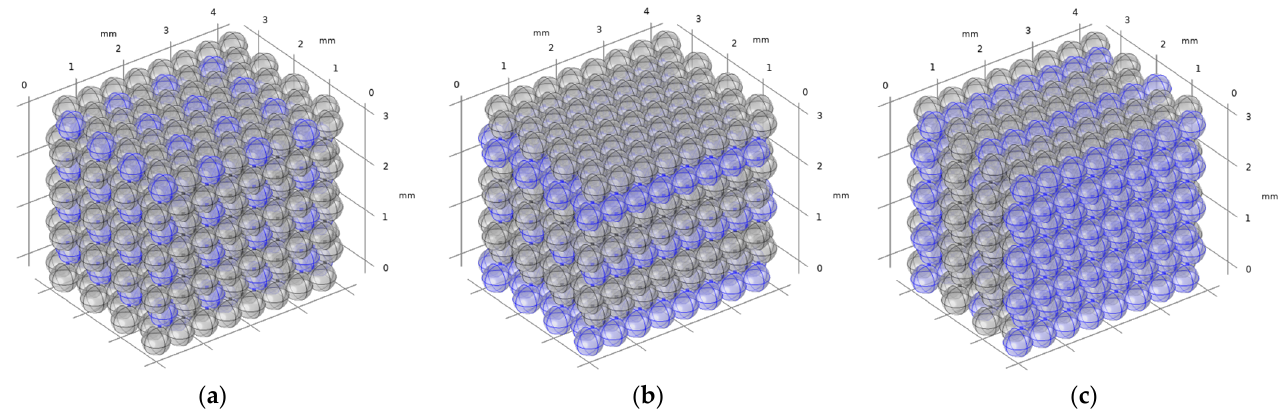
Figure 15. Model to examine the effect of clay content, the blue areas are clay. ( a ) Represents the structural clay; ( b ) represents the laminated clay in the xy plane; ( c ) represents the laminated clay in the xz plane.